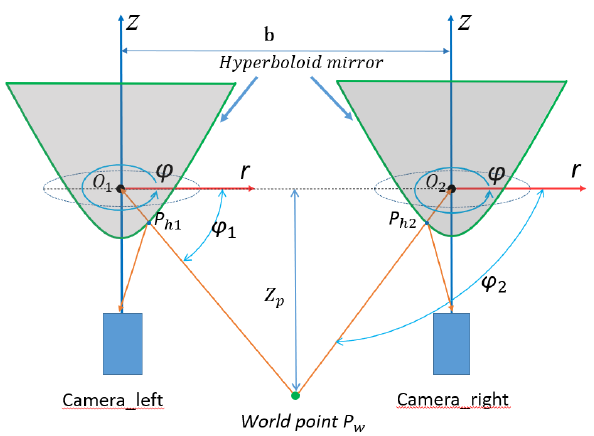
Figure 9. Coordinate systems of horizontal binocular stereo panoramic vision systems.